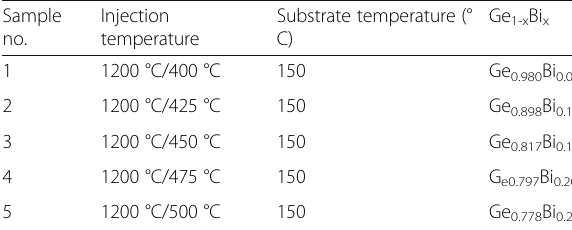
Table 1 Growth parameters of GeBi films Sample no.